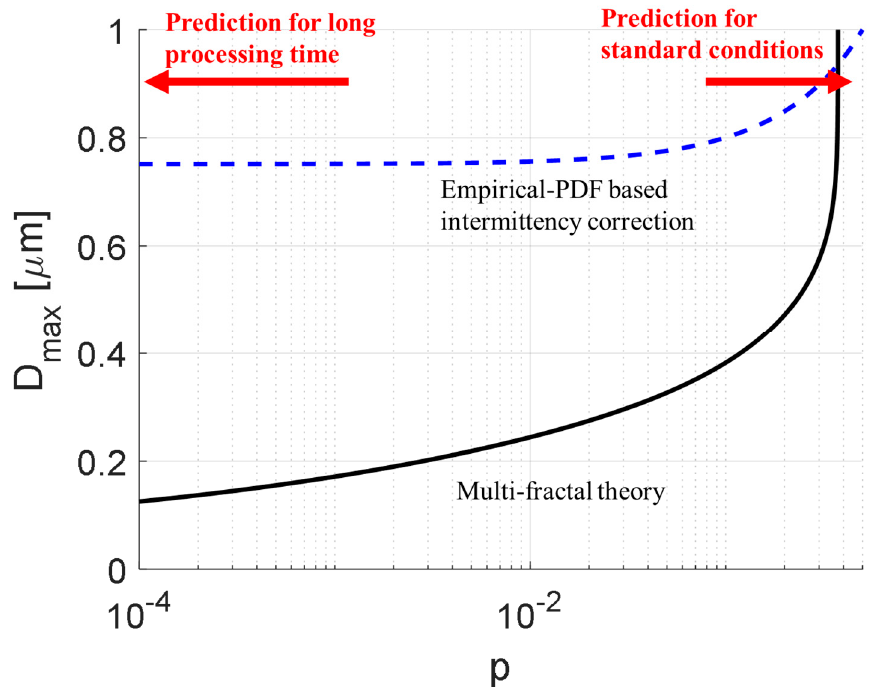
Figure 9. Comparing the predicted maximum drop diameter between the multi-fractal suggestion (Section 4.3) and the empirical-PDF based suggestion (Section 4.4), as a function of the limiting probability p required for having an instantaneous stress exceeding the stabilizing stress. Values of p ~ 1 correspond to cases where the drop spends a relatively short time-period in the turbulence (and thus only instantaneous stresses that occur with a high probability play a role) whereas p → 0 corresponds to when the drop spends a very long period of time in the turbulence (and thus even an instantaneous stress that only occurs with a low probability will play a role).